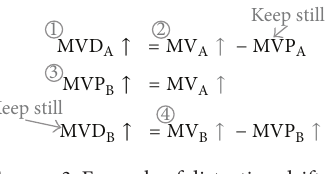
Figure 3: Example of distortion drift. Table 1: Comparison between original frame and frame with distortion drift. Original frame Frame with distortion drift